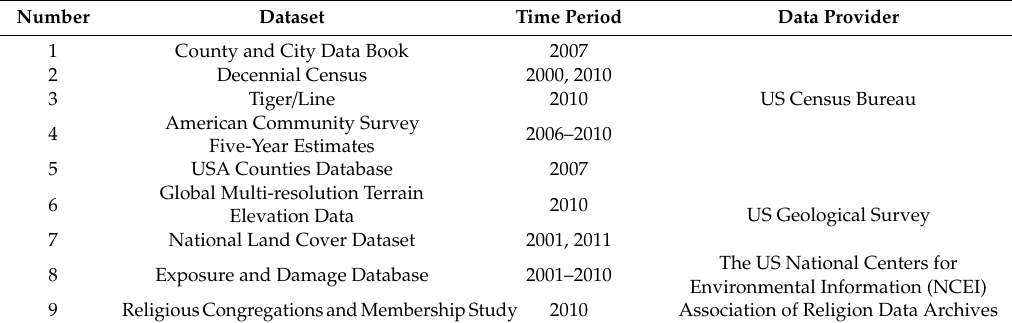
Table 1. Data sources and time periods used for indicators of disaster resilience